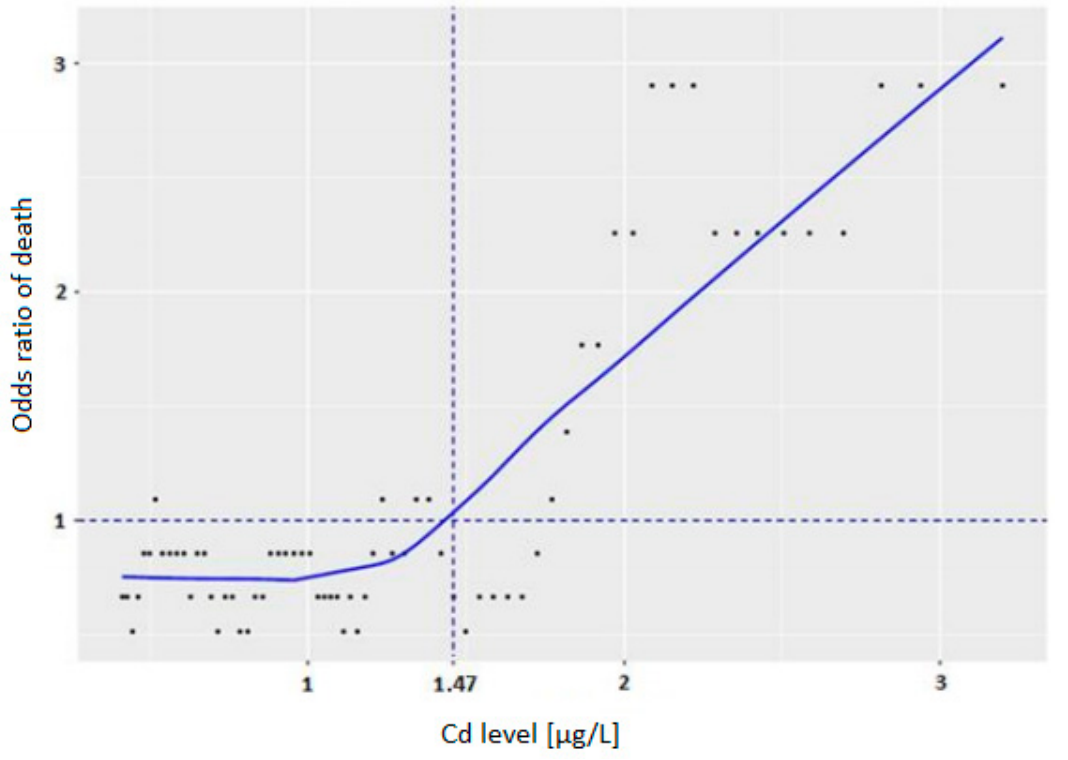
Figure 2. Cut-off point for Cd levels in stage IA disease.